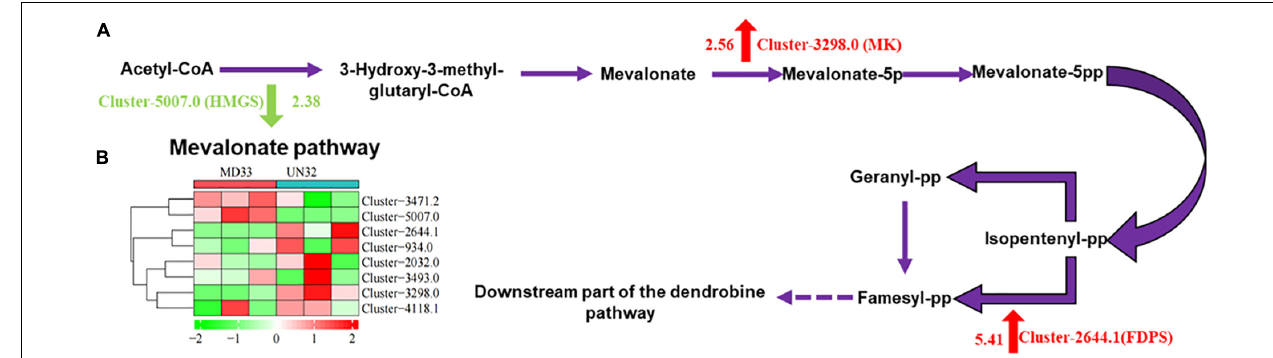
FIGURE 3 | Heat map of transcript abundance for genes related to MVA pathway. (A) Schematic illustration of MVA biosynthetic pathways in MD33. Abbreviations, as quoted in the figure, are as follows. HMGS, hydroxymethylglutaryl-CoA synthase; MK, mevalonate kinase; FDPS, farnesyl diphosphate synthase. (B) Expression changes of the genes associated with MVA pathway in the strain MD33 and UN32. Red indicates up-regulated genes and green indicates down-regulated genes.